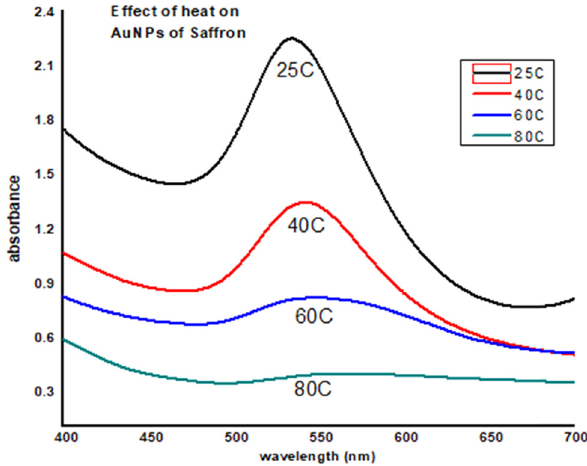
Figure 11: E ff ect of heat on sa ff ron stigma AuNPs ( SS - AuNPs )